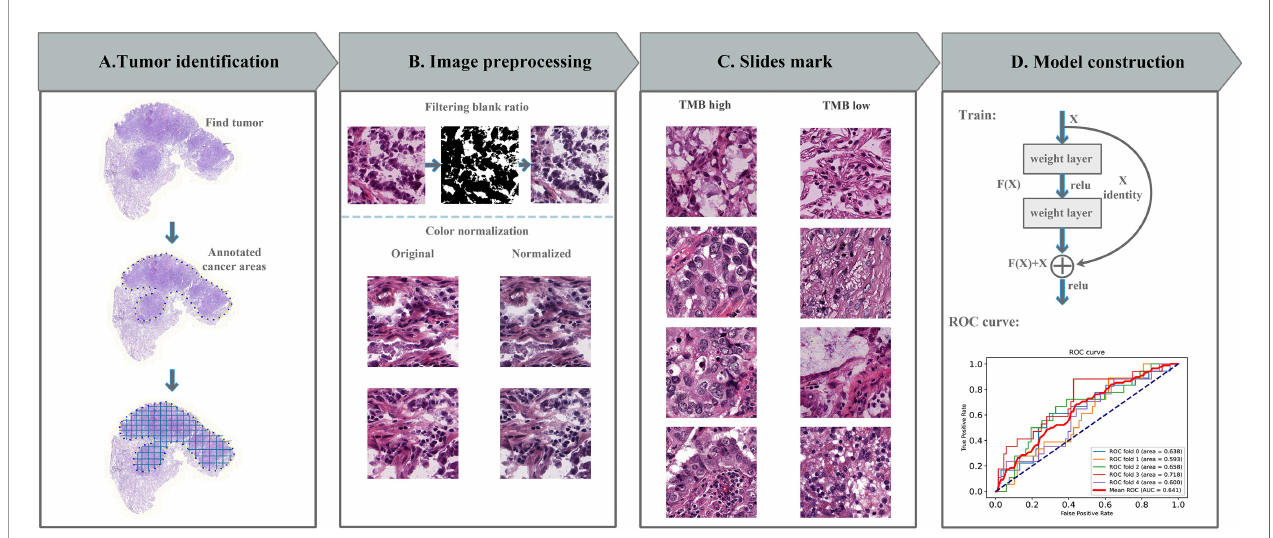
FIGURE 1 | Computational pipeline for predicting TMB in lung cancer. (A) The tumor area was annotated by a professional pathologist and cut into 512*512 image blocks. (B) Image processing includes noise reduction (discarding image blocks with a blank rate greater than 30%) and color normalization (Macenko method). (C) Divide TMB high and low with 10 as the threshold. (D) The prediction model was constructed with residual network, the model was tested with 5-fold cross- validation, and receiver operating characteristic (ROC) curve was used to evaluate the